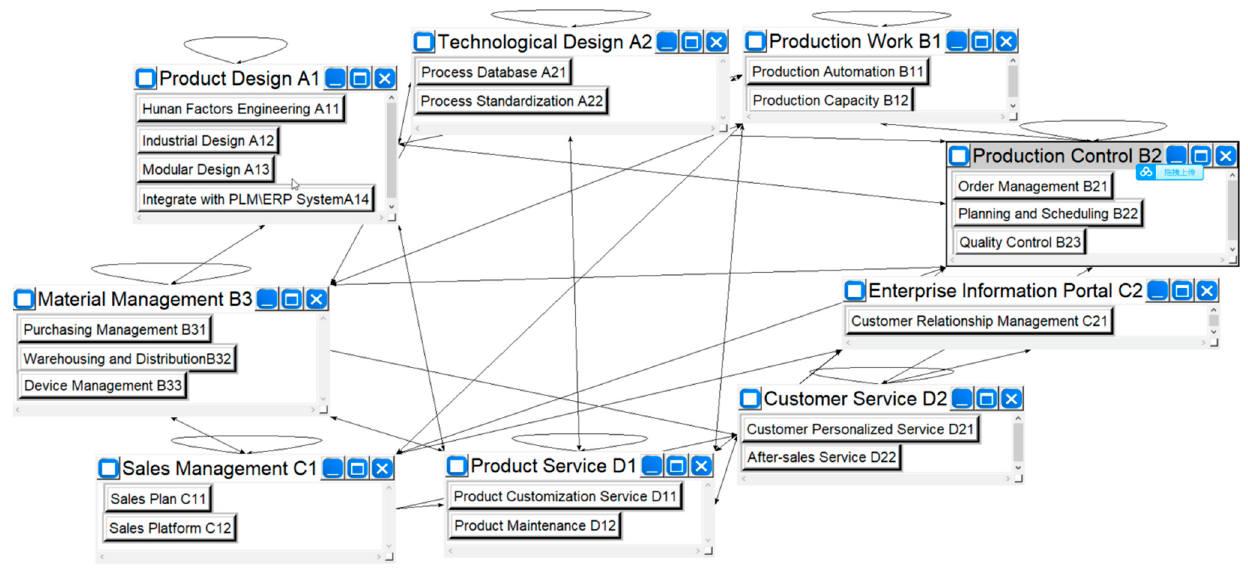
Figure 4. ANP evaluation model of intelligent manufacturing capability maturity of chair industry enterprises.